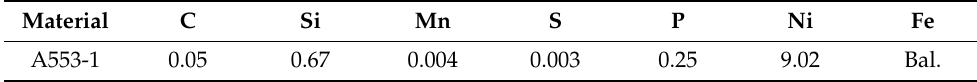
Table 1. Chemical composition of 9% nickel steel (wt%).